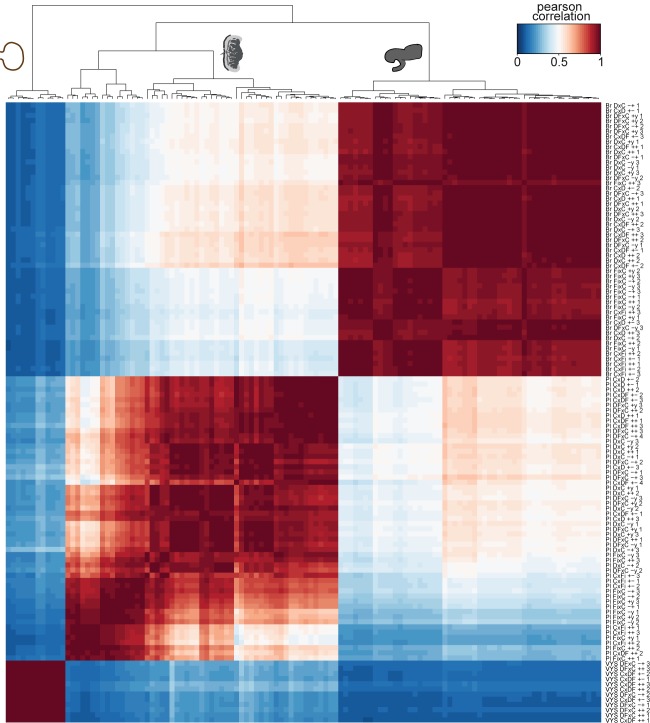
RNA-seq quality control from F1 brains, placentas, and visceral yolk sacs.Heatmap showing unsupervised clustering of a Pearson correlation matrix (120 brain, placenta, and visceral yolk sac samples) from expression data (TPM), confirming the expected developmental relationship.